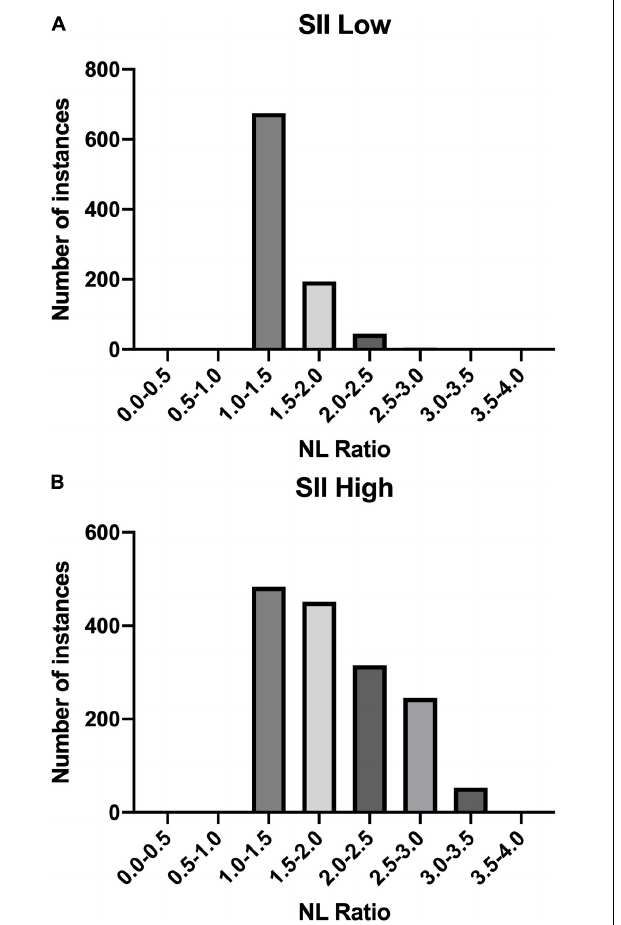
FIGURE 3 | Quantities of patients in buckets of NL Ratio values, grouped according to their Vitamin D status: (A) I T (1.11 – 9.40]; (B) II T (9.40 – 17.69]; (C) III T (17.69 – 25.97].